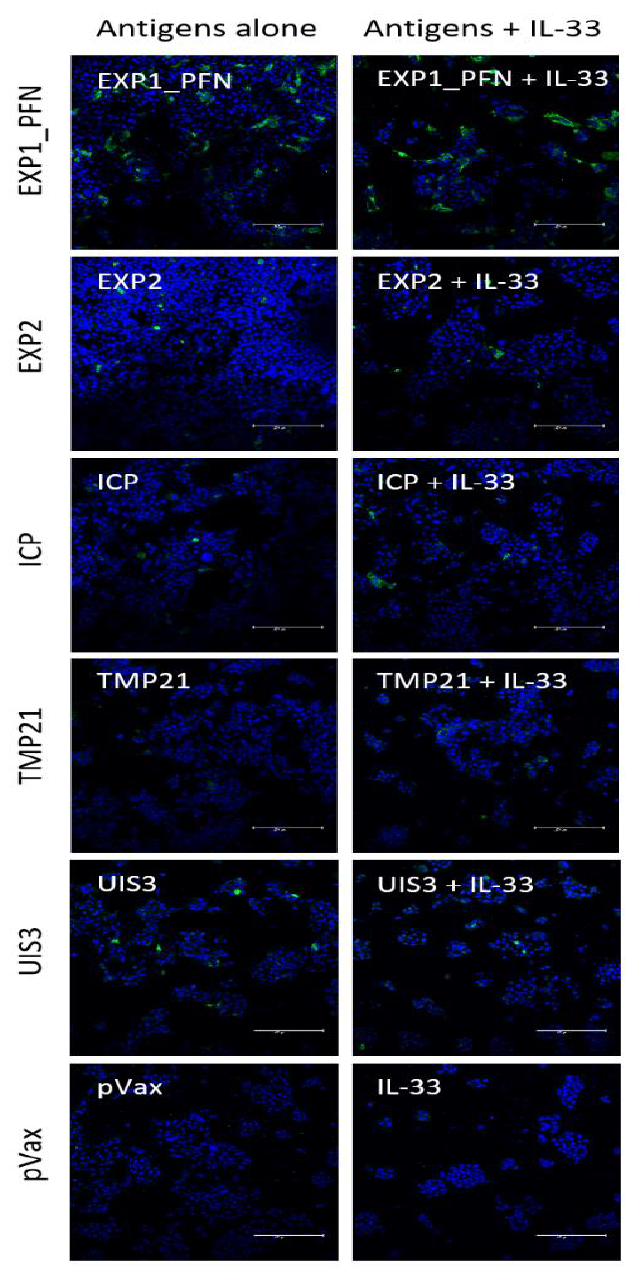
Figure 5. Antibodies elicited by Py DNA vaccines in mice. Hepa1–6 cells were transfected with the DNA vaccine construct listed on the left. Cells were then probed with pooled mouse post-immune sera collected 1 week after the last immunization. An anti-mouse-IgG-AF488 was used as a secondary antibody to detect the presence of anti- Py antigen antibodies. DAPI staining shows cell nuclei. White text in the top left corner of each field indicates post-immune sera vaccine group.